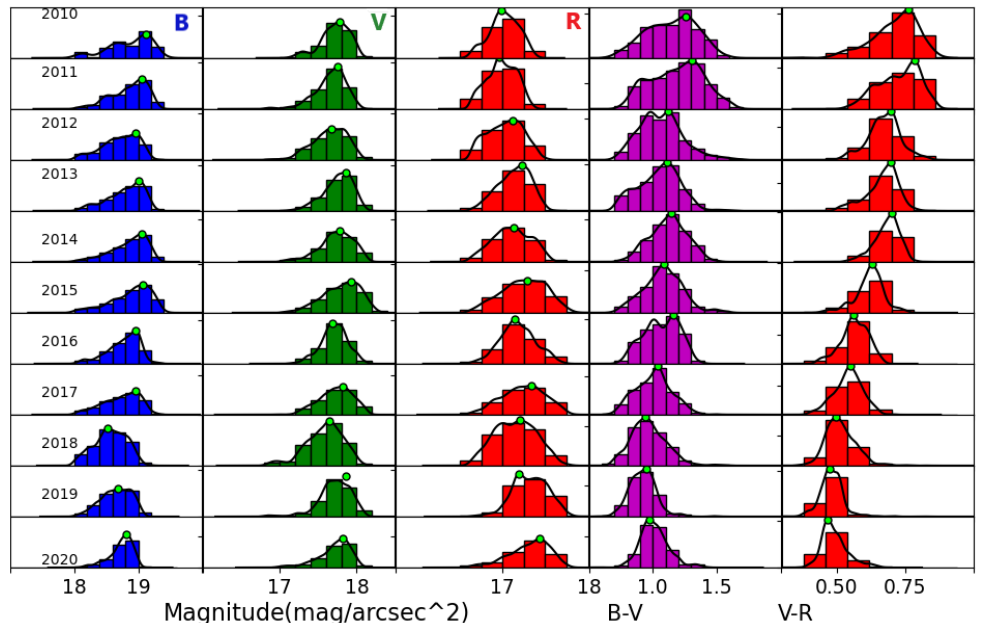
Figure 8. AstMon. Night sky brightness and color index histograms for filtered data before midnight. From left to right, histograms for the Johnson B, V, R, B-V, and V-R color indices. Green points represent the modes. The black curves represent the Kernel Density Estimation (KDE) that can be interpreted as the goodness-of-fit.